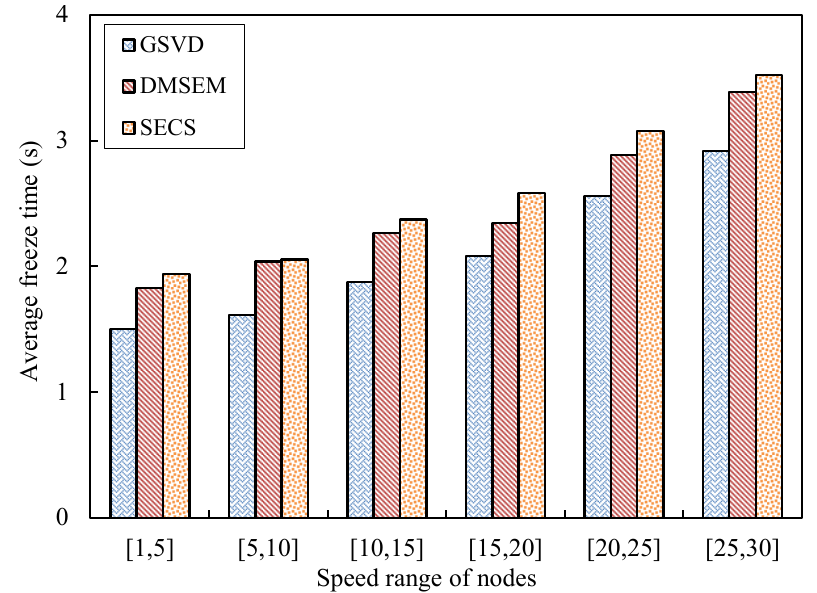
Figure 10. Average freeze time against the various speed ranges of the nodes. Loss of video data and variation of the transmission delay are the main reasons of video freeze in the process of stream transmission. In order to reduce the risk of data loss and variation levels of delay, GSVD measures the video delivery quality by estimation of the transmission delay and data loss rate in the process of video data delivery. GSVD further makes use of the estimation of video delivery quality to allocate the optimal video supply nodes for the video request nodes and support the reselection supply nodes when the performance of data transmission decreases. The mobility-adapted video delivery can achieve a high performance of video data with a low delay and PLR. Therefore, the AFT values of GSVD are less than those of DMSEM and SECS. However, the fast movement of mobile nodes increases the variation levels of geographical location, which leads to